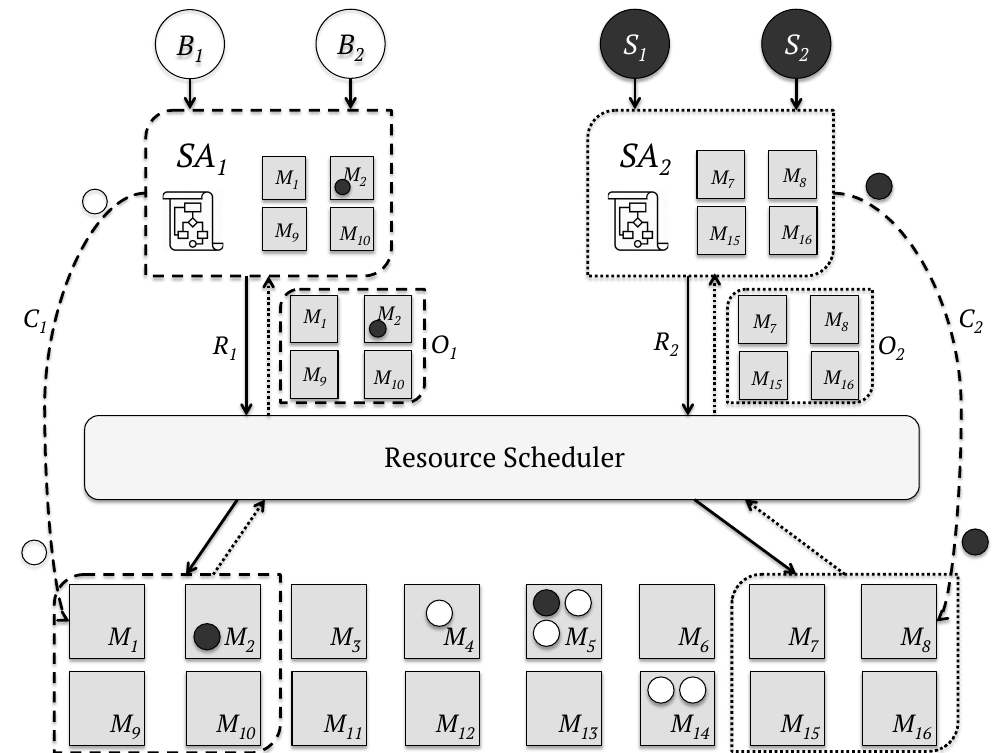
Figure 2. Two-level scheduler architecture. C, commit; O, resource offer; SA-, scheduler agent